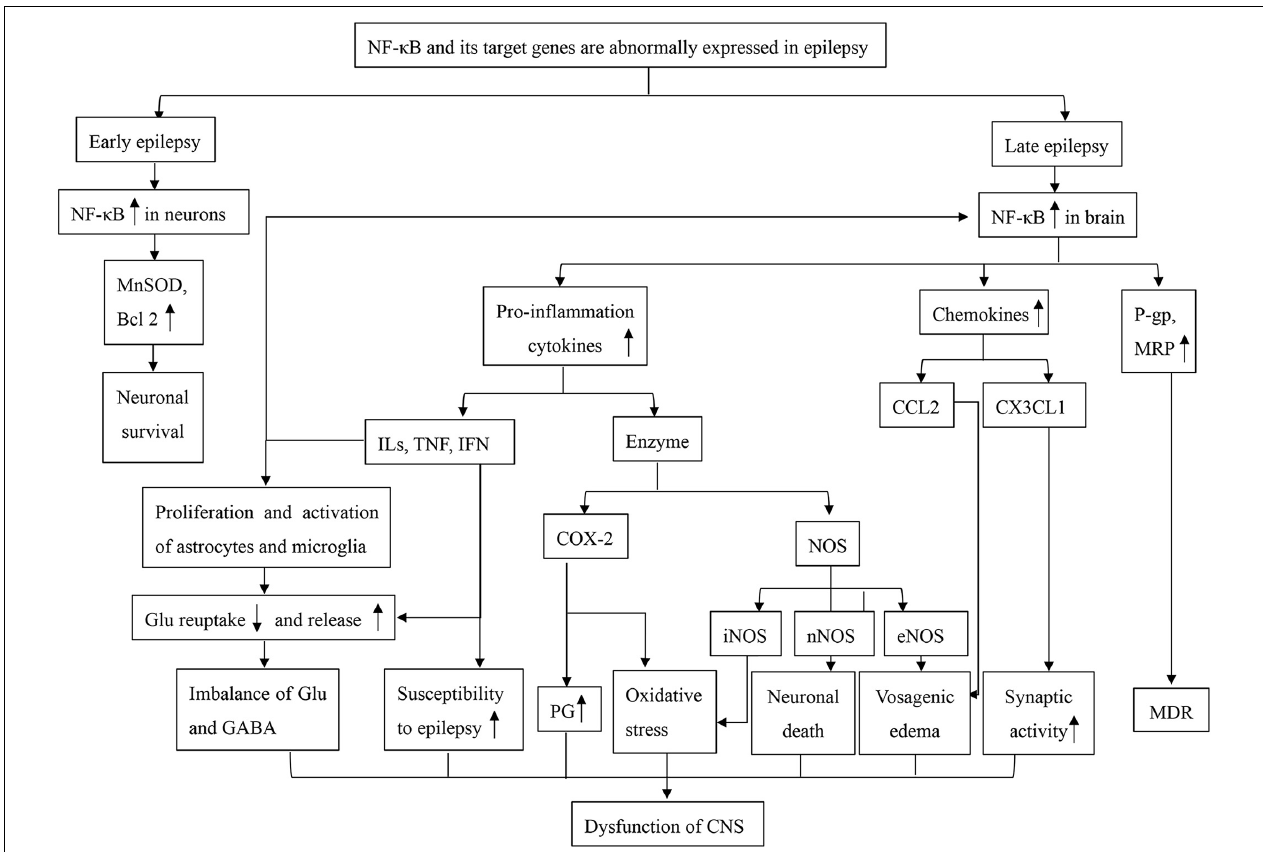
FIGURE 1 | A mind map of NF- κ B dysfunction in epilepsy. Bcl2, B-cell lymphoma-2; CCL2, chemokine (C-C motif) ligand 2; COX-2, cyclooxygenase 2; CX3CL1, fractalkine; Glu, glutamate; GABA, γ -aminobutyric acid; ILs, interleukins; IFN, interferons; MnSOD, manganese-superoxide dismutase; MRP, multidrug resistance protein; MDR, multiple drug resistance; NF- κ B, nuclear factor kappa B; NOS, nitric oxide synthase; eNOS, endothelial nitric oxide synthase; iNOS, inducible nitric oxide synthase; nNOS, neuronal nitric oxide synthase; PG, prostaglandin; P-gp, P-glycoprotein; TNF, Tumor Necrosis